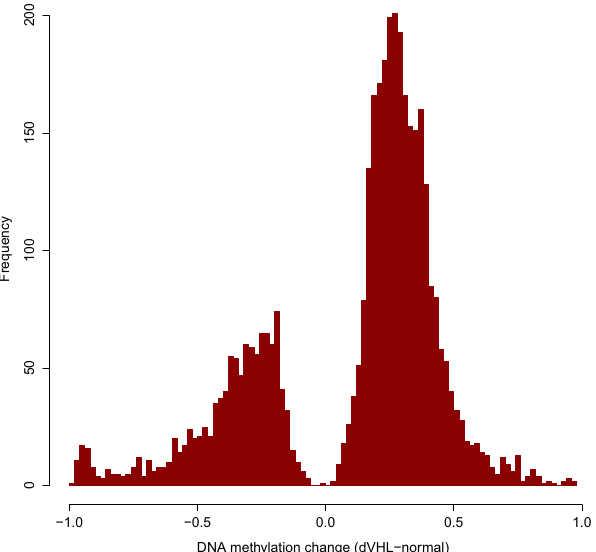
Figure 2. Distribution of changes in DNA methylation rates at individual CpGs following VHL inactivation. Only CpG positions which significantly changed their DNA methylation level were considered. DNA is on average hypermethylated after VHL